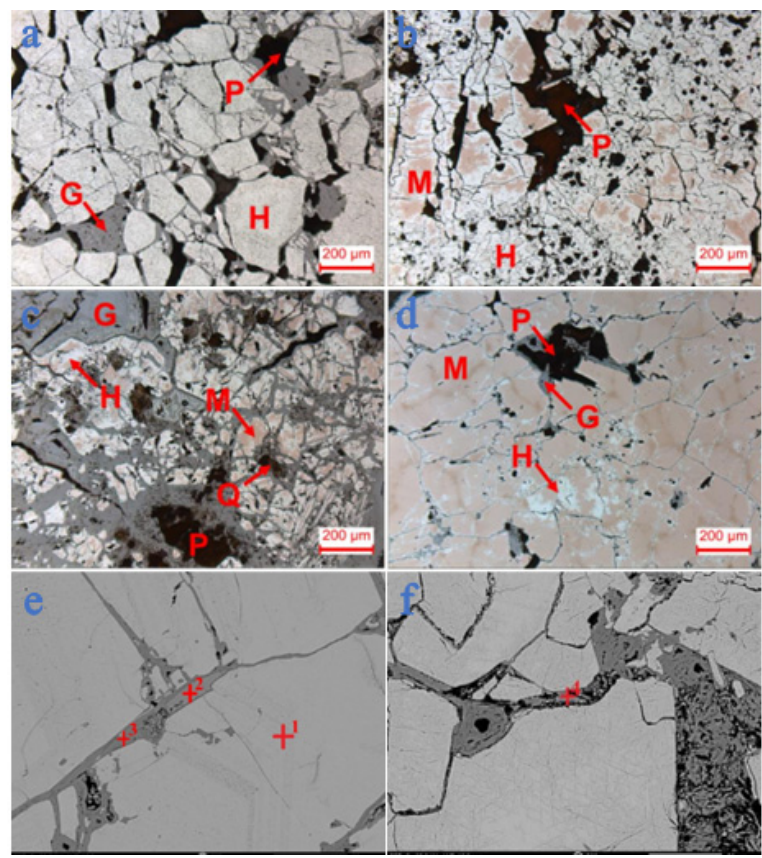
Figure 2. Microstructure and main physical phases of lump A. ( a ‐ f ) Table 4. EDS analysis results for areas in Figure